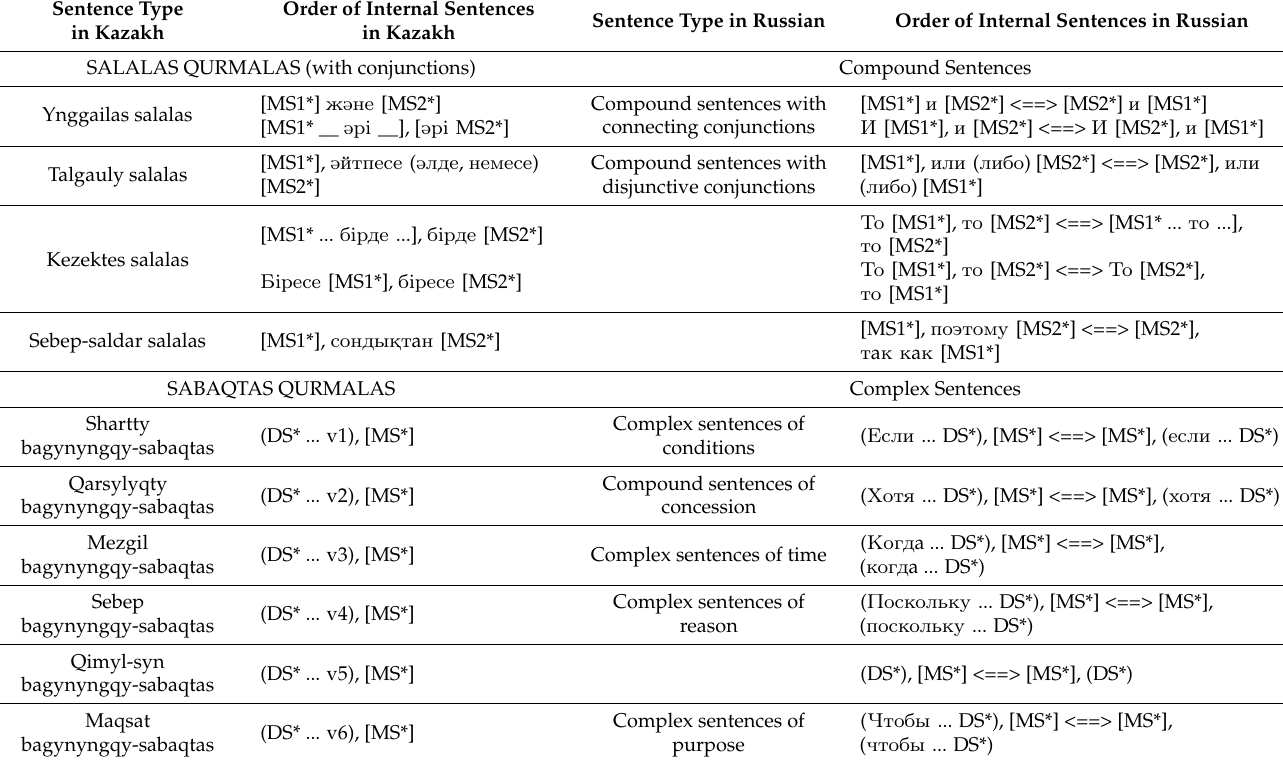
Table 3. Model of the order of internal sentences of a complex